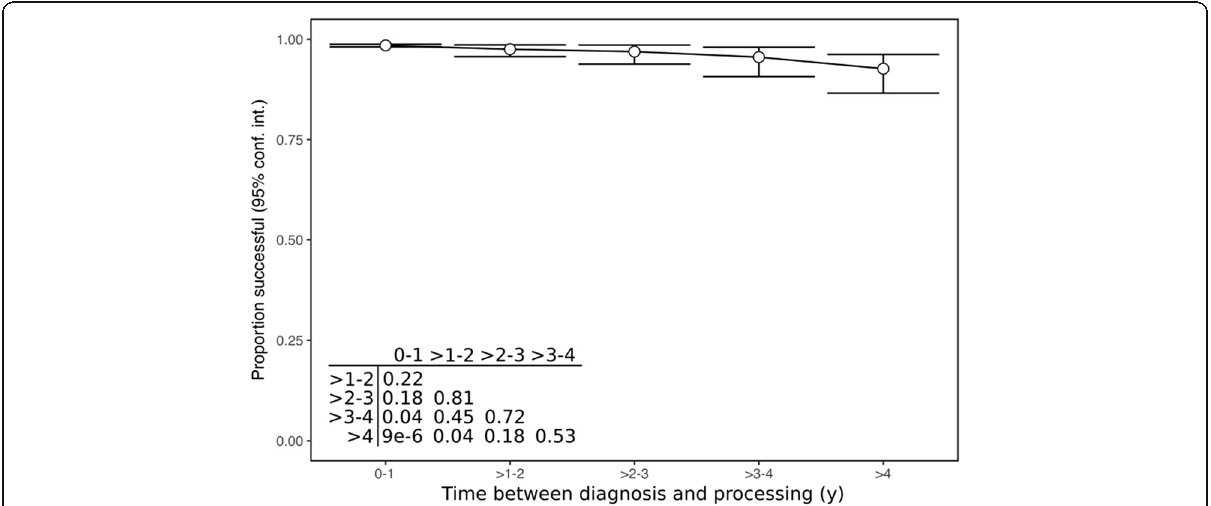
Fig. 3 Success rates for the DecisionDx-Melanoma test for FFPE samples at various time points after diagnosis. Processing times are in years since diagnosis. Error bars represent 95% confidence intervals for the proportion of successful GEP tests in the indicated bin. Inset table represents the adjusted (FDR) p -values of Chi-squared comparisons between the indicated time